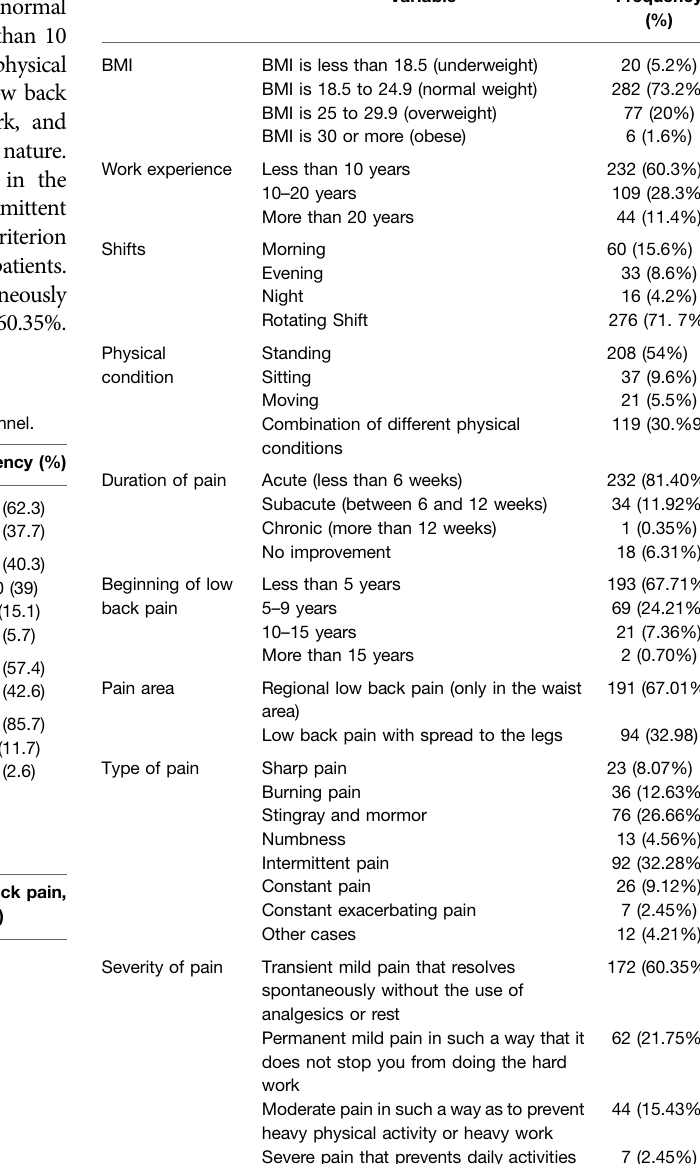
TABLE 3 | Clinical characterization of low back pain among operating room